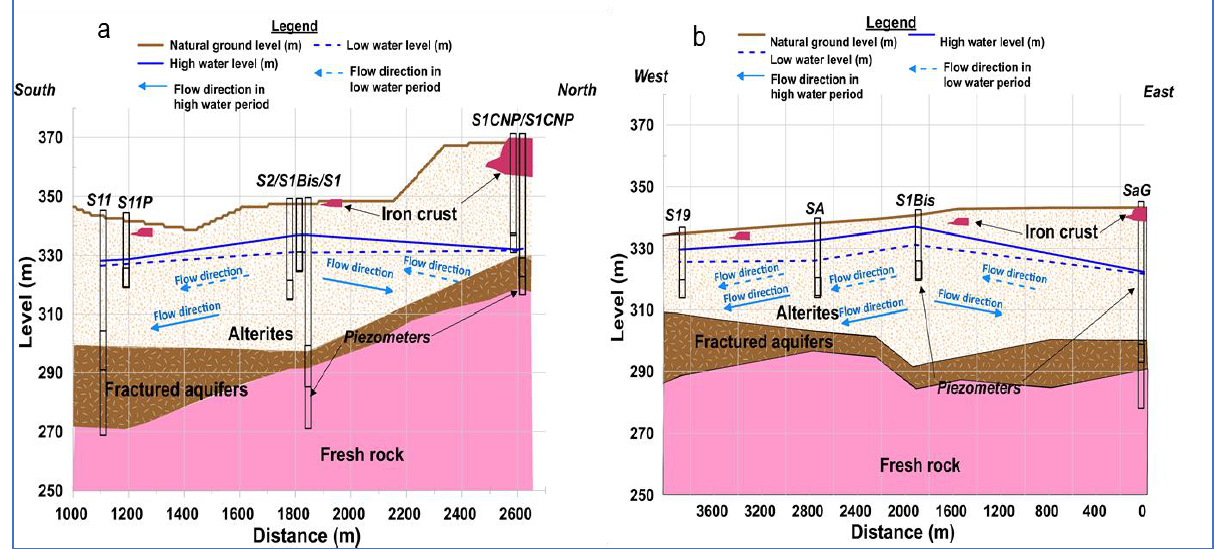
Figure 3. Evolution of piezometric levels and water flow direction (low and high water) along two transects: ( a ) north–south transect T1 and ( b ) west–east transect T2.